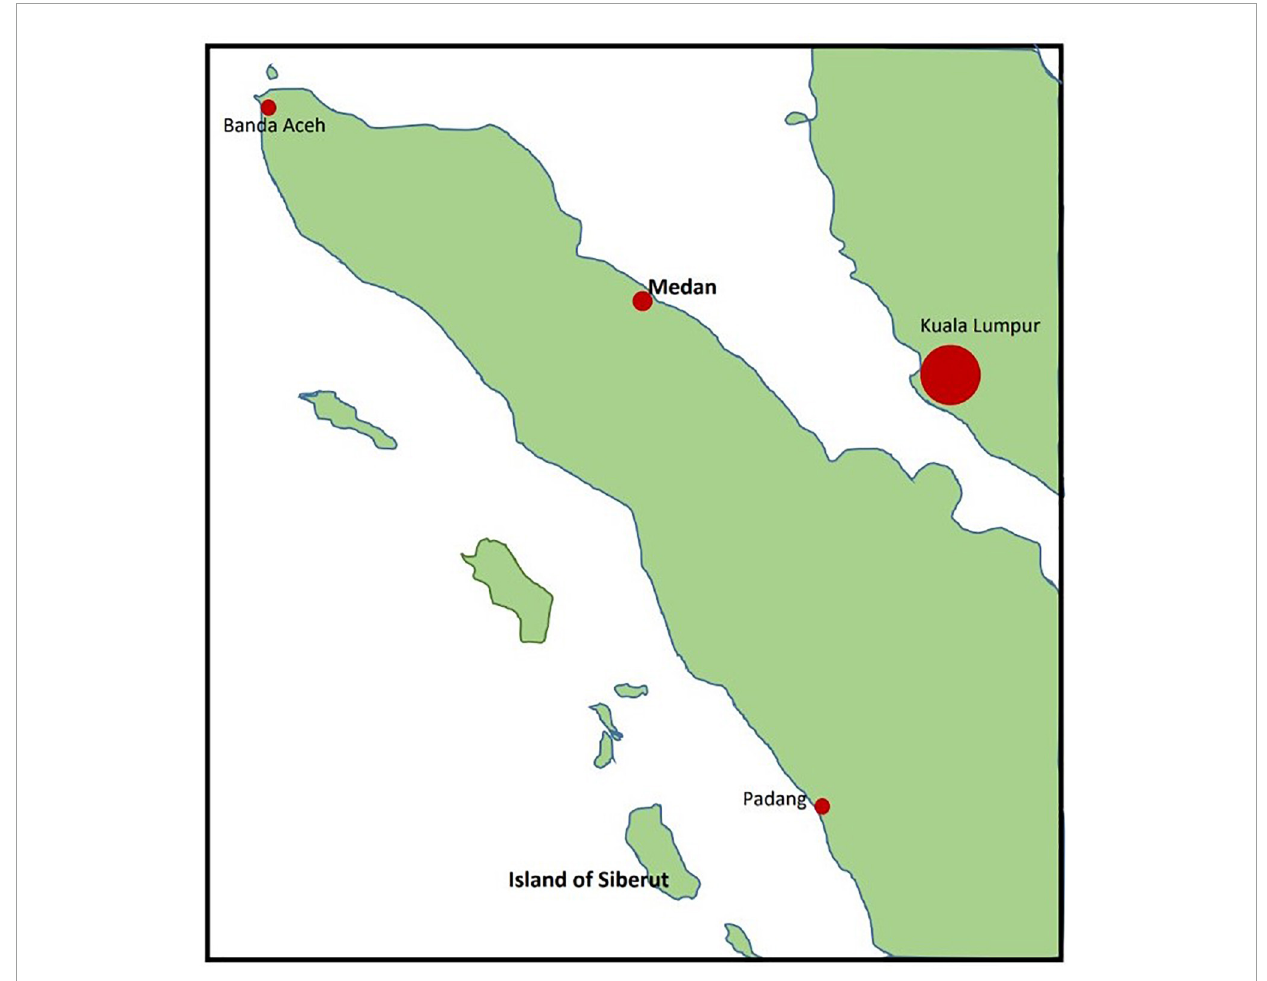
FIGURE1 Overview of the location of the two Indonesian study